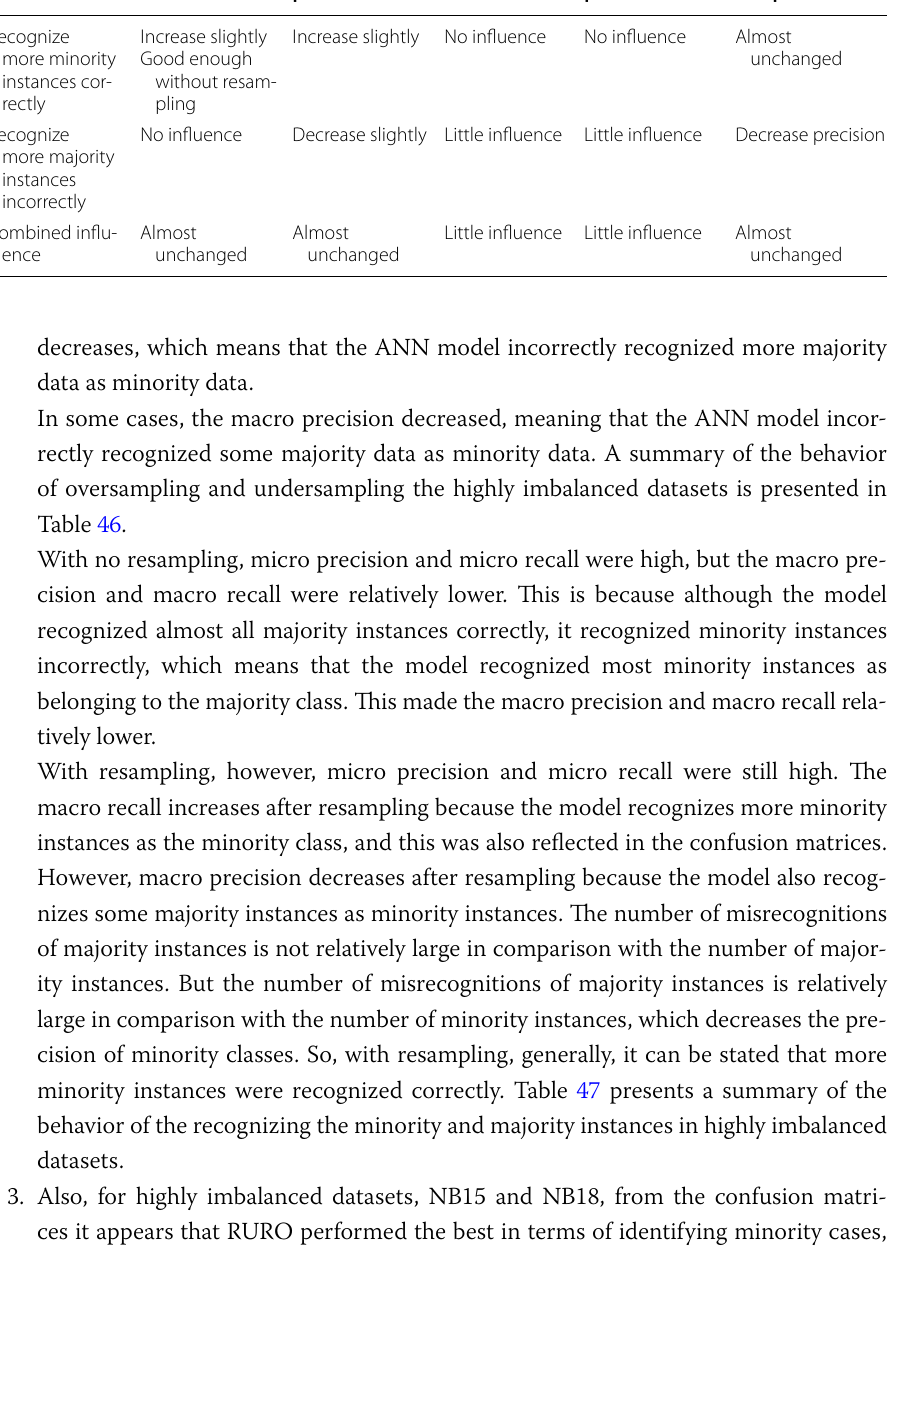
Recognize more minority Recognize more majority Combined influ-